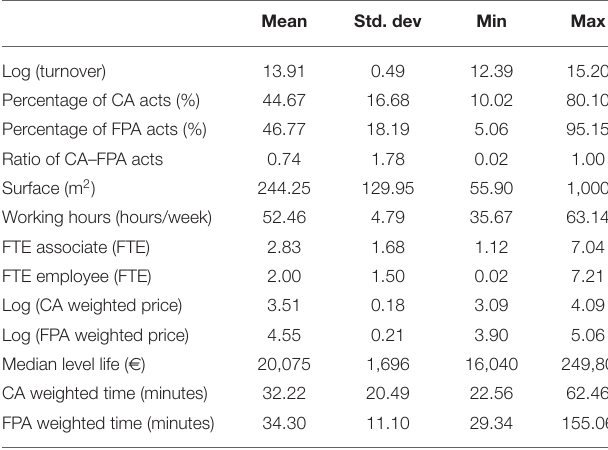
TABLE 2 | Descriptive statistics of quantitative variables used in regression models and PCA.